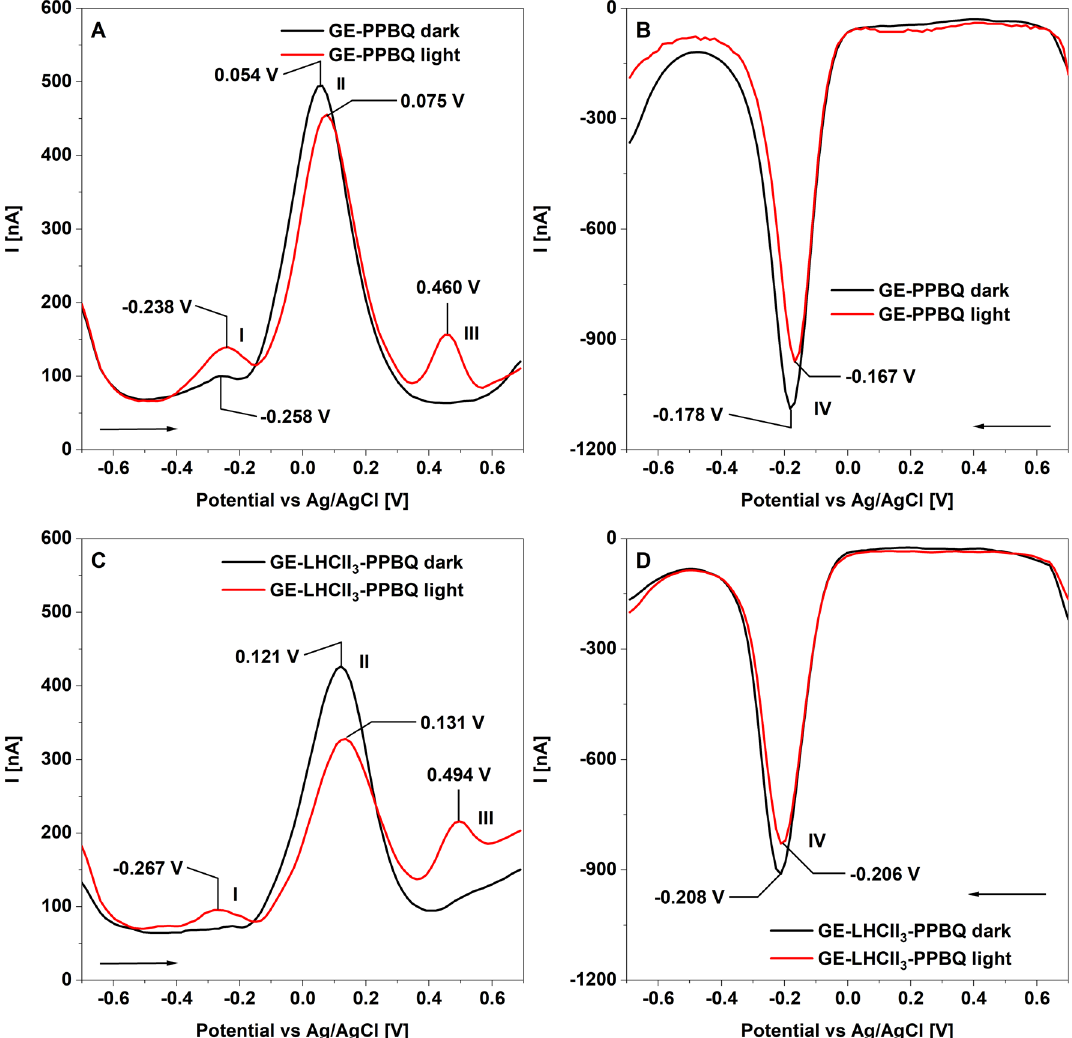
Figure 4. Voltammetric characterization of the interaction between LHCII 3 and PPBQ. Differential pulse voltammograms (DPV) of GE-PPBQ ( A , B ) and GE-LHCII 3 -PPBQ ( C , D ) for oxidation ( A , C ) and reduction ( B , D ) processes were recorded under dark (black lines) and light (red lines) conditions. The measurements were performed in special holders and samples were illuminated with actinic white light with the intensity of 4900 µE. PPBQ was used at 0.1 mM concentration. The arrows indicate the direction of the potential change. Curves were smoothed using a polynomial fixed order available through NOVA software. The presented voltammograms are representative of at least 3 separate experiments.